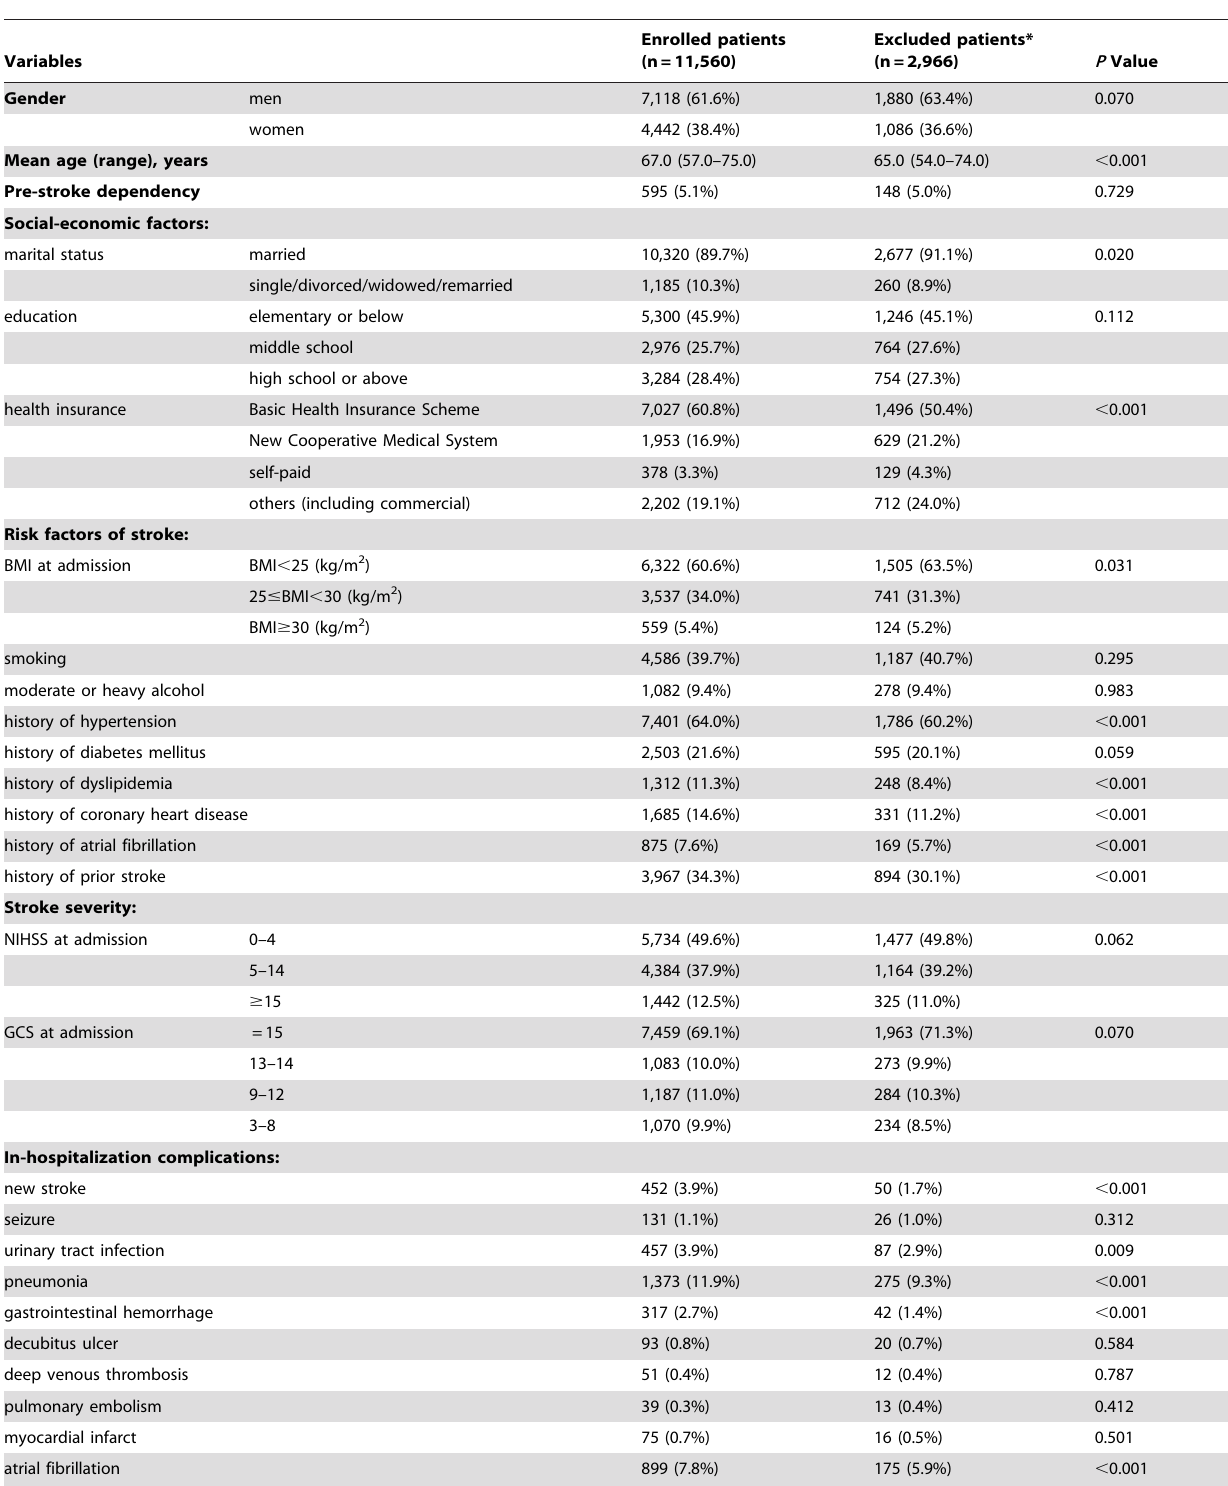
Table 1. Baseline characteristics of enrolled and excluded patients with ischemic stroke.